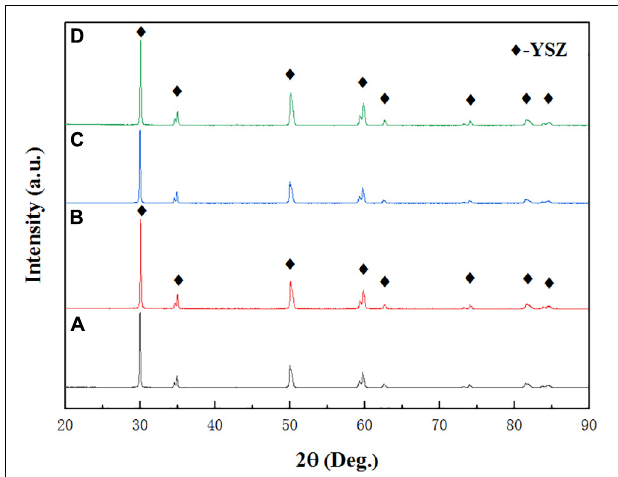
FIGURE 9 | XRD patterns of the different coating systems: coating C50N50Y200 (A) before and (B) after thermal ablation test, coating C50N50Y200 (C) before and (D) after thermal ablation